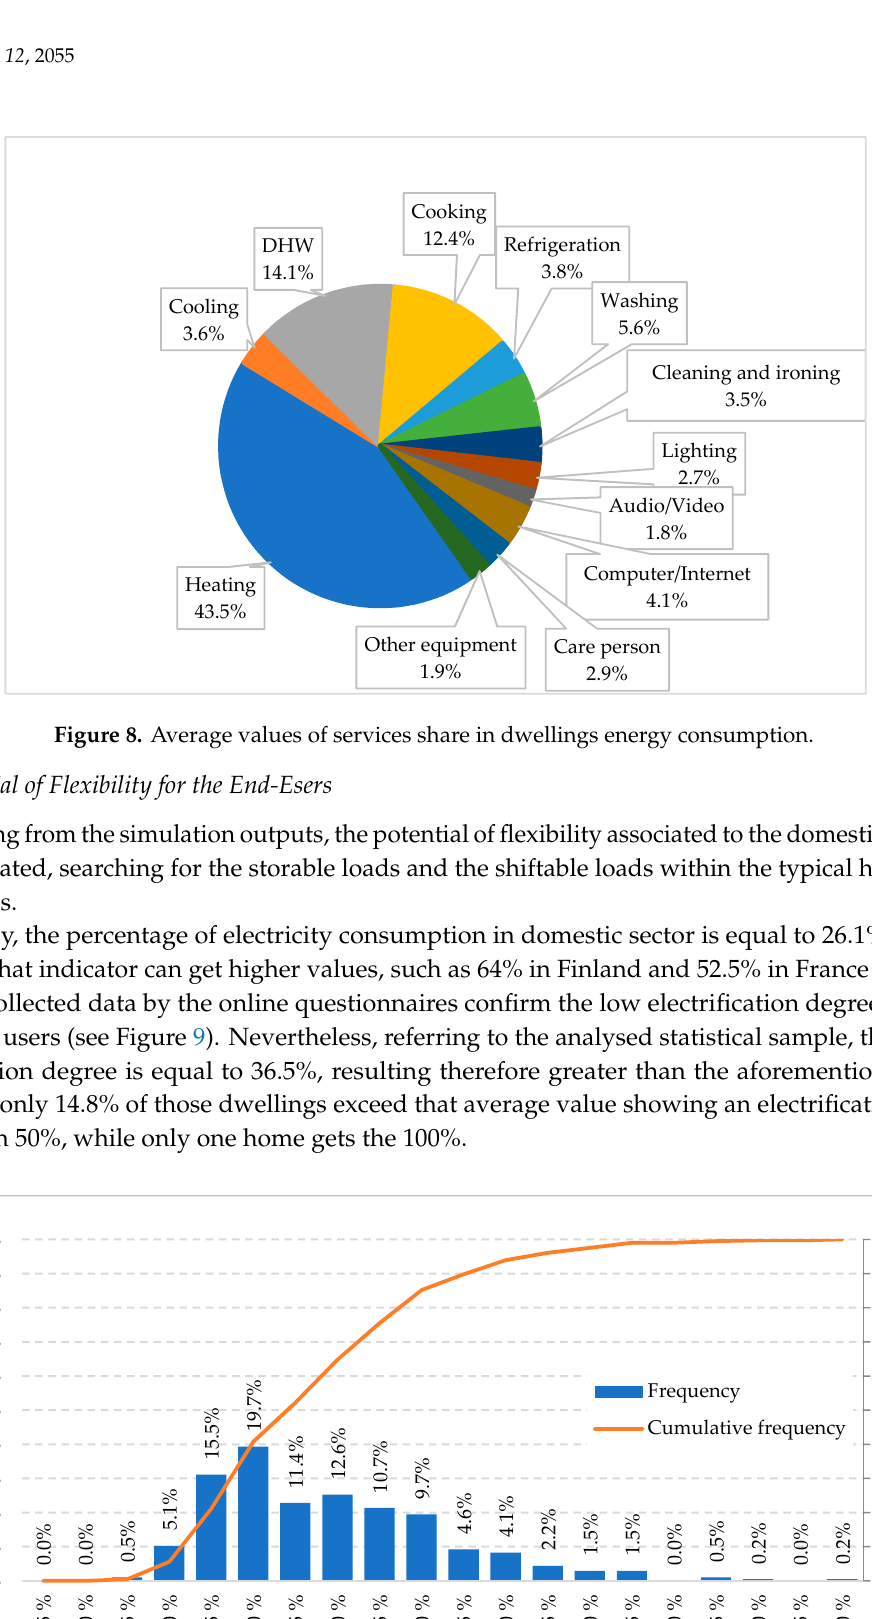
Figure 7. Services share in dwellings energy consumption.